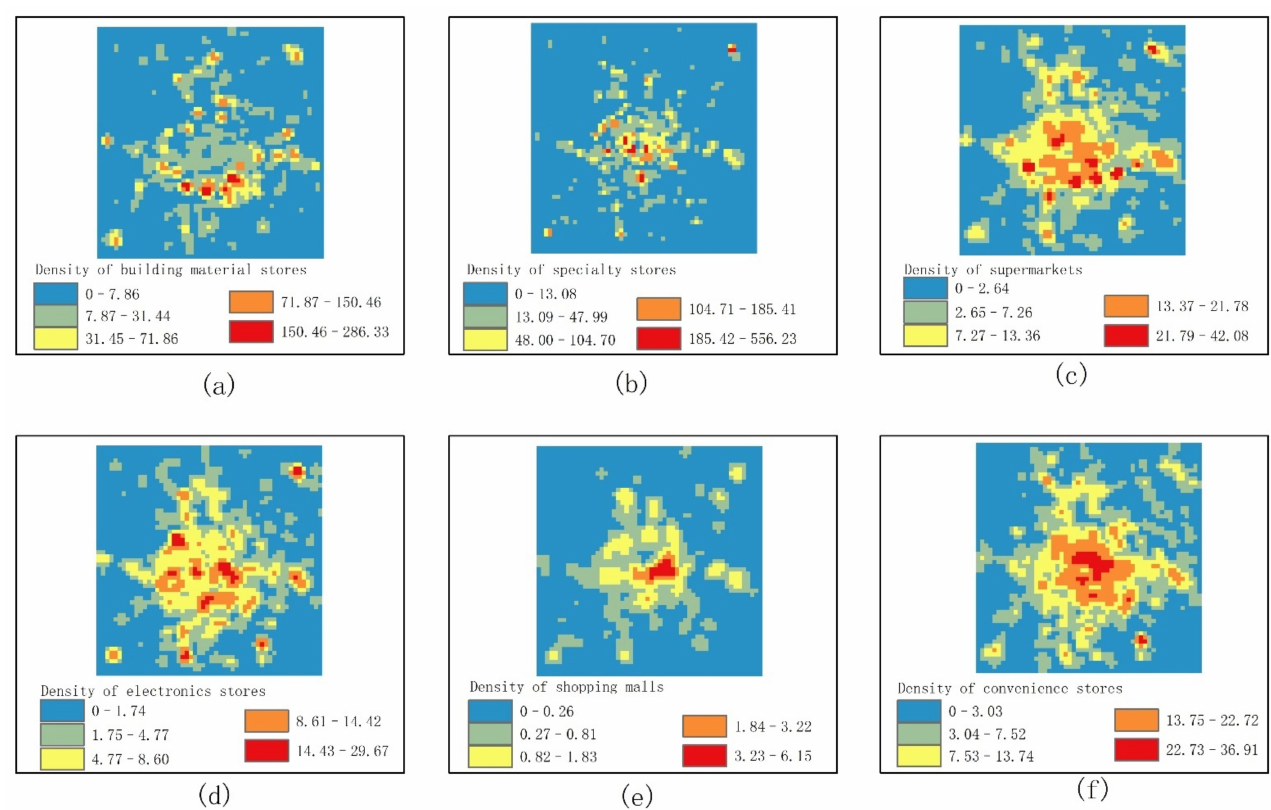
Figure 3. Density distributions of different types of retail stores determined by KDE: ( a ) building material stores; ( b ) specialty stores; ( c ) supermarkets; ( d ) electronics stores; ( e ) shopping malls; ( f ) convenience stores.